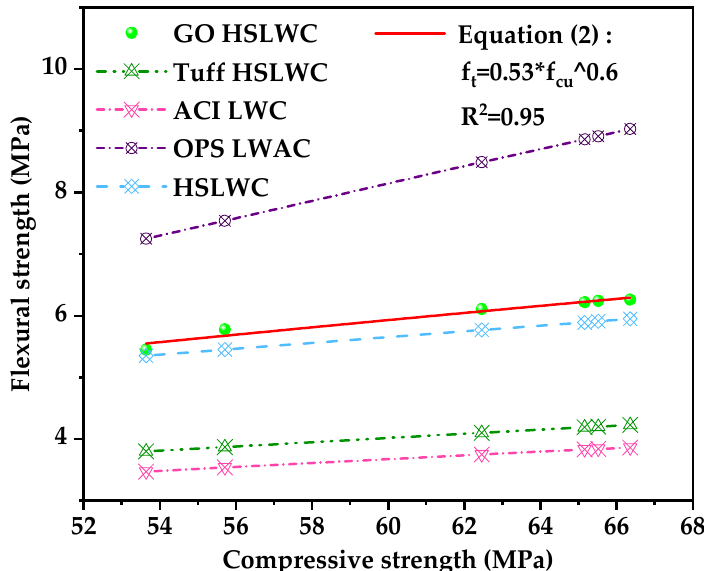
Figure 8. Relationship between compressive strength and flexural strength of concrete.